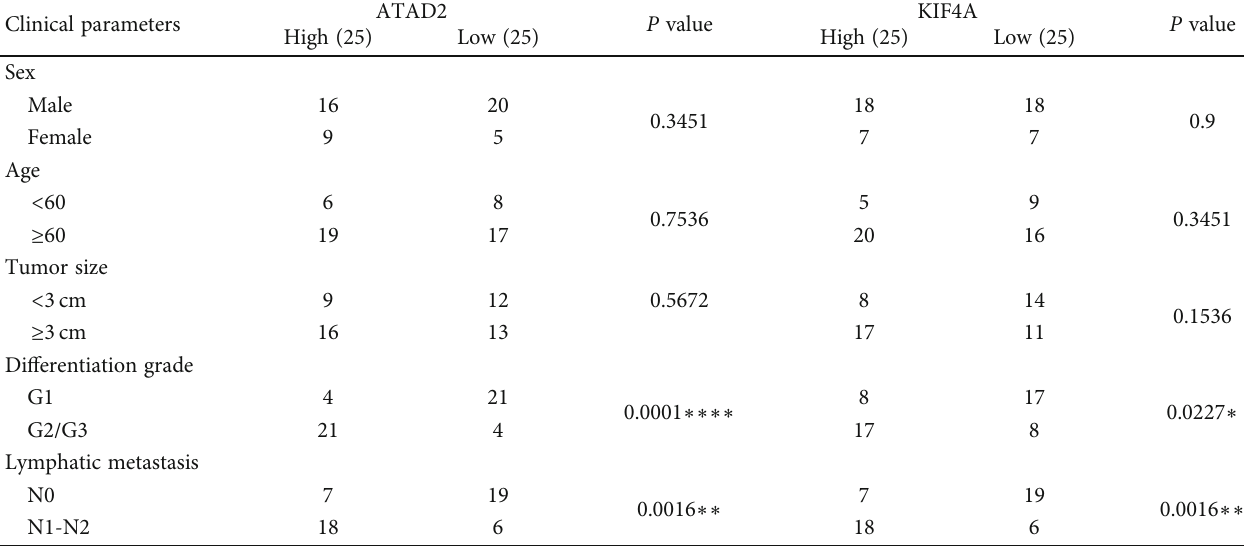
Table 3: The relationship between the expression of ATAD2 and KIF4A and clinicopathological parameters in ESCC a patients. Clinical parameters